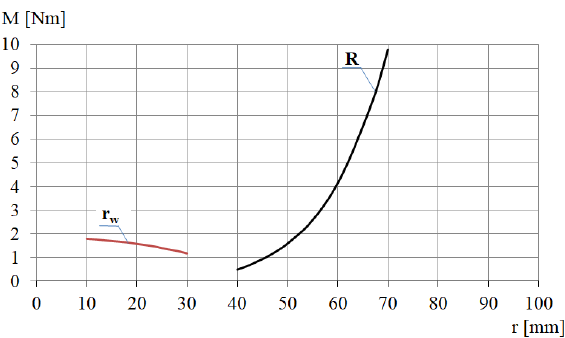
Figure 7. Dependence of the torque on the radius r w and on the radius R.